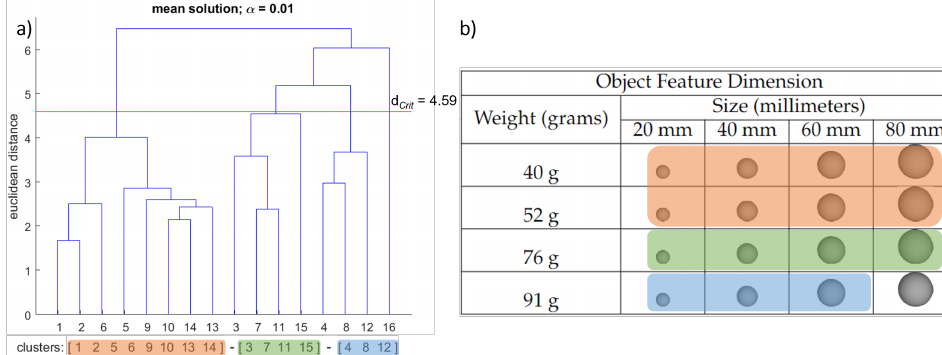
Figure 2. Results averaged among participants for the “weight condition”. ( a ) Mean dendrogram showing the resulting sensorimotor representation structure. The red horizontal line denotes the Euclidean critical distance. The critical value of the Euclidean distance was 4.59 at a 1% level of signif- icance (i.e., d Crit = 4.59, α = 0.01). Clusters that occur beneath the horizontal red line are statistically significant. ( b ) Spheres used in the experiment with their corresponding feature dimension levels. ( a , b ) Each color represents a significant cluster and its corresponding subset of spheres.